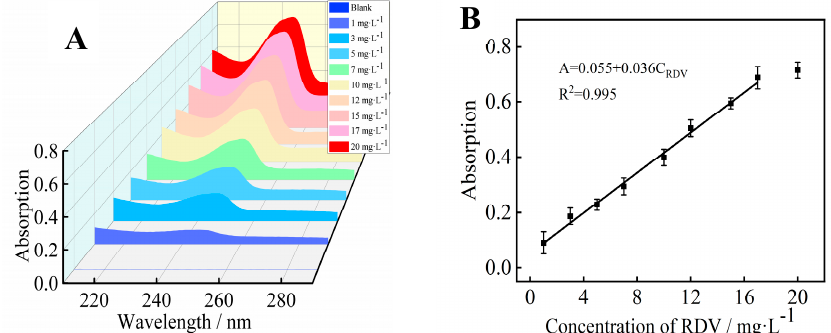
Figure 2. UV-vis spectra of varying concentrations of RDV ( A ) and the correlation between UV-vis intensity and concentration of RDV ( B ).